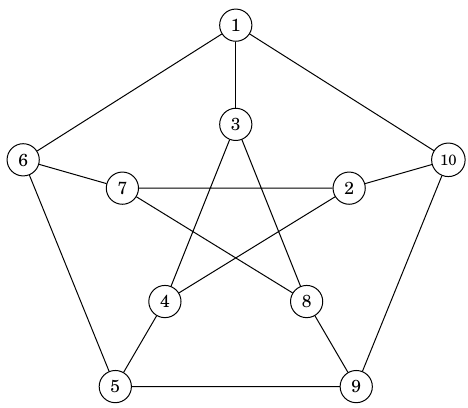
Figure 6: A strongly quotient labeling.